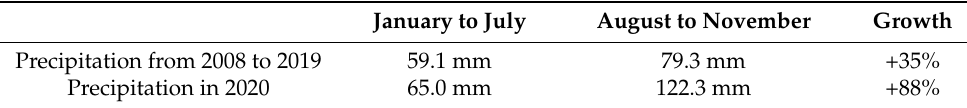
Table 9. Comparison of actual precipitation in Liupan